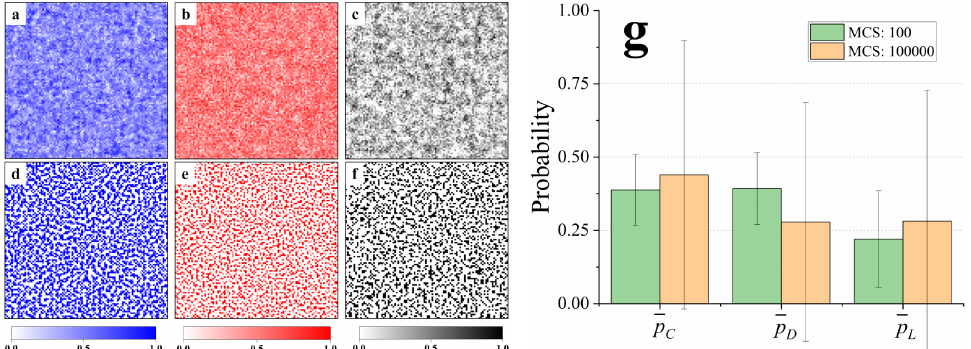
Figure 6. Distributions of p C , p D and p L in the population, as ( a – c ) MCS = 100 and ( d – f ) MCS = 100,000 for ω C = ω D = 0.02. The probabilities of C , D, and L in mixed strategy are shown in various degrees of blue, red, and black, respectively. ( g ) Statistical data of the mixed strategies of the population in different evolutionary periods. The other parameters are r = 3.5, α = 1, γ + = γ − = 0.5, λ = 2, and M =